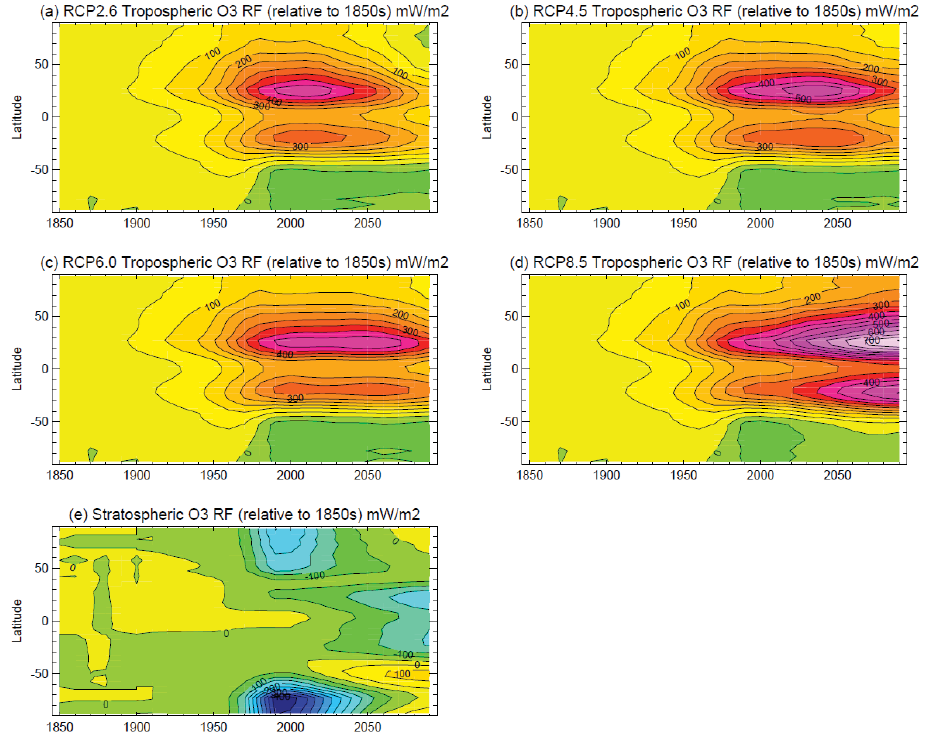
Fig. 16. Zonal mean radiative forcing, 1850s to the 2090s, (a–d) tropospheric ozone for four future scenarios (RCP2.6, RCP4.5, RCP6.0 and RCP8.5); and (e) stratospheric ozone (single scenario).